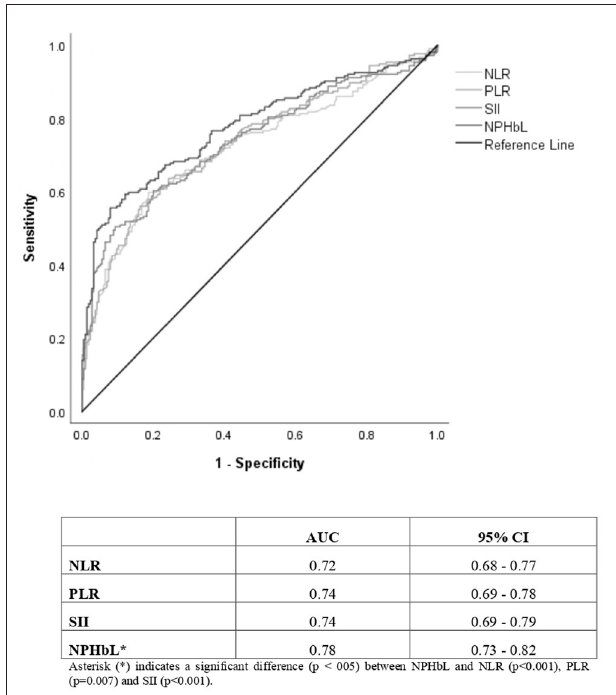
FIGURE 2 | ROC (receiver-operating characteristic) curves and area under the curve (AUC) with confidence interval (95% CI) of the inflammatory markers based on CRC diagnosis as the outcome variable. NLR, neutrophil-to-lymphocyte ratio; PLR, platelet-to-lymphocyte ratio; SII, systemic immune-inflammation index; NP/LHb, neutrophils x platelets/lymphocytes x hemoglobin ratio; CI, confidence interval.